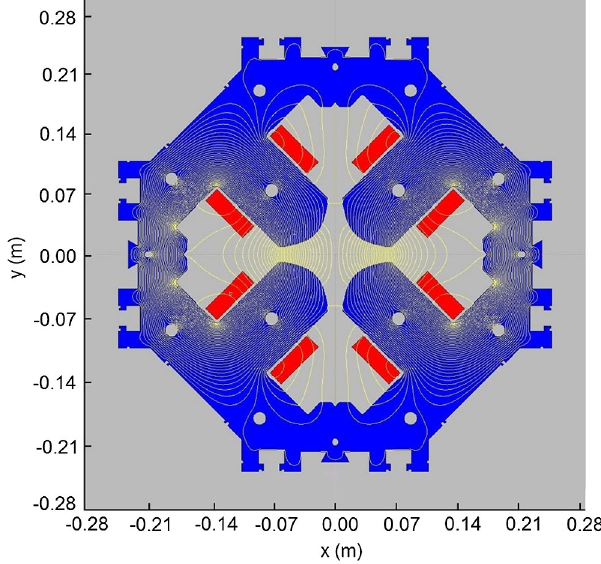
FIG. 17. Schematic of cERL injector steering coils wound on the poles of quadrupole magnets with the bore radius of 3 cm and core length of 10 cm. Simulated magnetic field lines are also